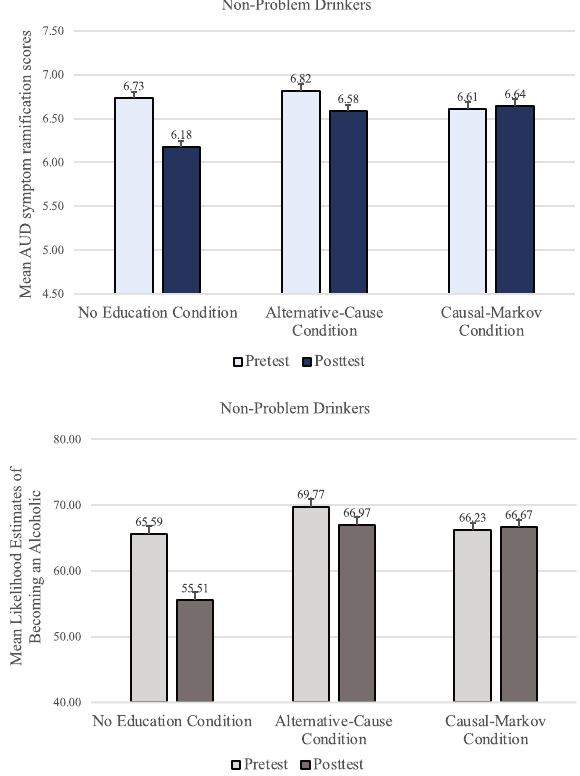
Figure 6. Non-problem-drinkers’ mean AUD symptom ramification scores and mean likelihood estimates of becoming an alcoholic in Study 3. Error bars represent SEM pairedDiff